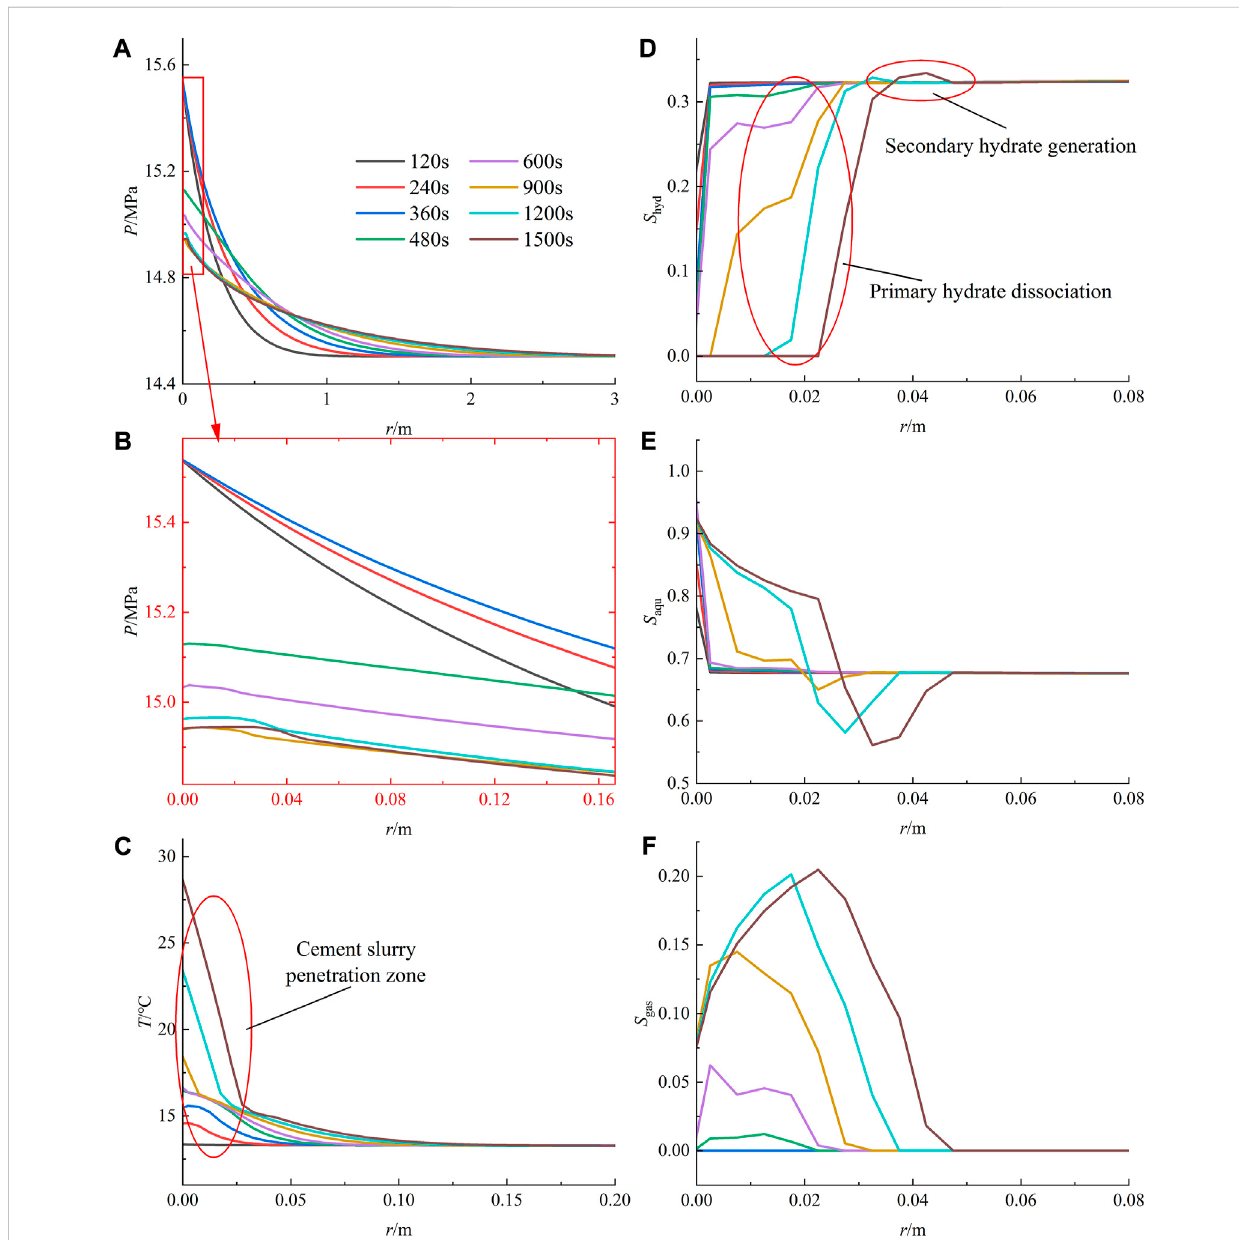
FIGURE 6 Changes in the main physical properties of the sediment at different times during cement slurry penetration. (A) Pressure. (B) Pressure local ampli fi cation. (C) Temperature. (D) Hydrate saturation. (E) Liquid saturation. (F) Gas saturation.